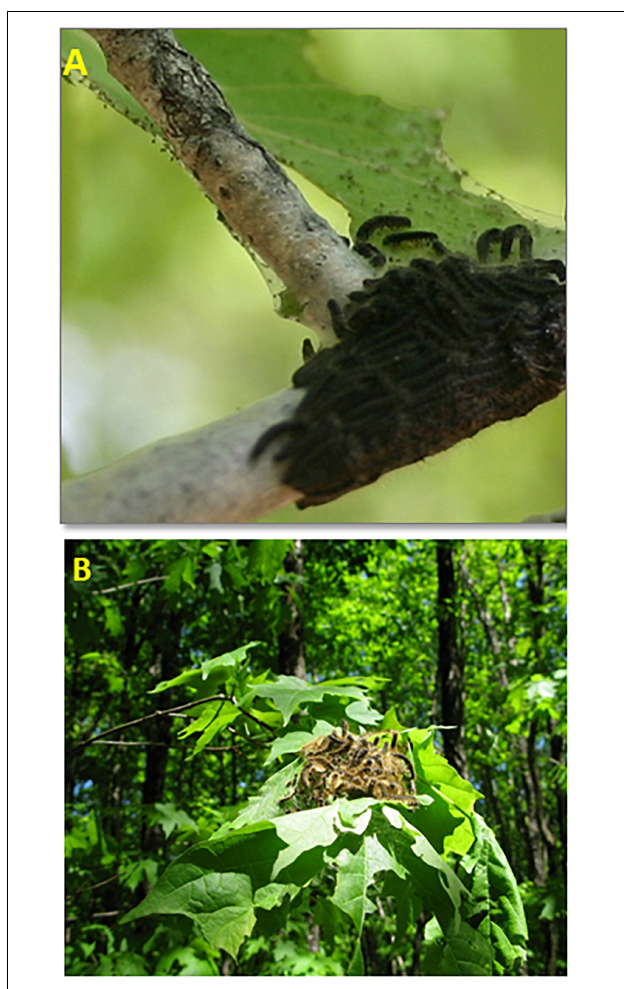
FIGURE 2 | Thermoregulatory cooperation: Malacosoma disstria (A) second instar (body length 1–1.5 cm) and (B) fifth instar (body length > 5 cm) caterpillars basking collectively to increase body temperature in the boreal forest of Québec, Canada.